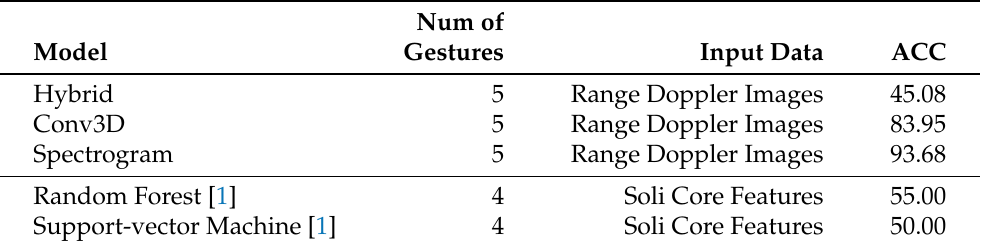
Table 4. Comparison of proposed model architectures with standard machine learning techniques on the same gesture